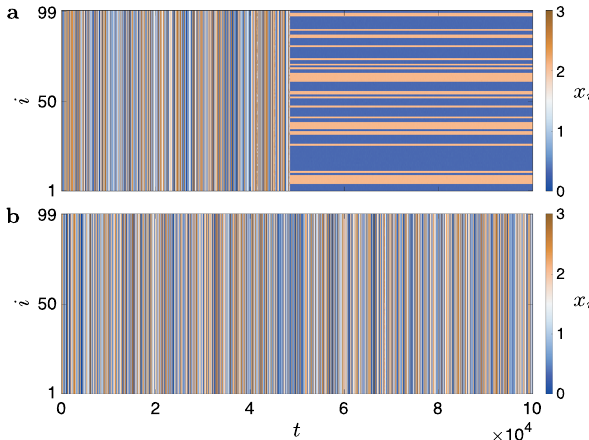
Fig. 6 Improved synchronization in aperiodic and noncommutative temporal networks. The temporal networks are based on the discrete- switching networks given by Eq. (22), which are further made aperiodic and noncommutative by applying random Gaussian perturbations of zero mean to the strength of each edge independently at every time step t . The standard deviation of the perturbations is fi xed at 0.1/ n (10% of the average edge weight). The spacetime plots show the evolution of the optoelectronic oscillators on temporal networks with a : temporal activity A = 0 and b : temporal activity A = 0.15. Both systems are initialized close to the synchronous state. Synchronization persists only in the second system, even though the network in the fi rst system is an optimal static network (a complete graph with uniform edge weights). Other parameters are set to n = 99, T = 10, β = 2.8, and σ =